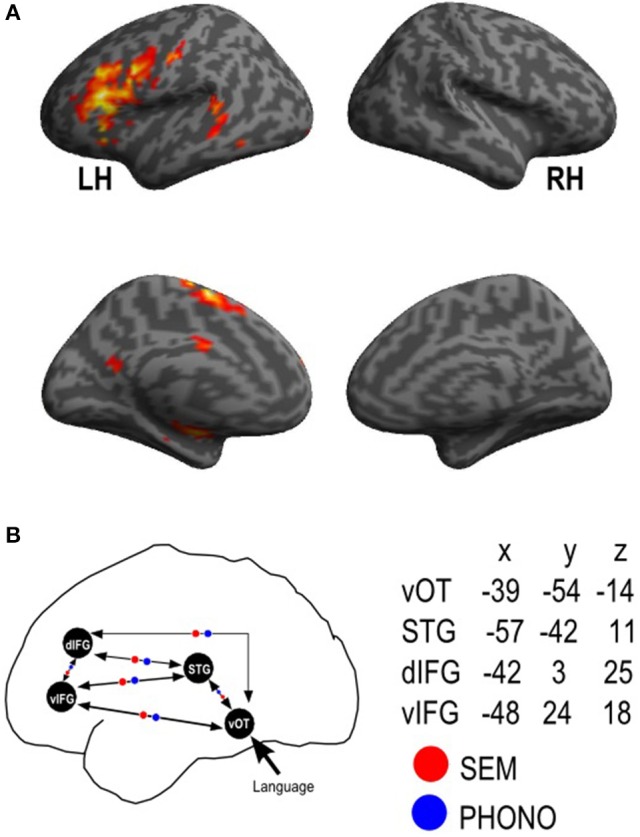
Functional MRI activation results and ROI dynamic causal model definition. fMRI results provided by the random-effect group analyses for the (A) Language vs. Control; Activation is projected onto lateral and medial surface rendering templates; (B) represents a schematic view of the connectivity model with the four regions of interest (vOT, STG, dIFG, vIFG, mean peak MNI coordinates were also presented) and reciprocal endogenous connections between all the regions. The external input (“Language”) reaches first the vOT region. Modulatory parameters are indicated in red for SEM (semantic) condition and in blue for PHONO (phonological) condition. LH, left hemisphere; RH, right hemisphere; vOT, ventral occipito-temporal cortex; STG, superior temporal gyrus; dIFG, dorsal inferior frontal gyrus; vIFG, ventral inferior frontal gyrus.